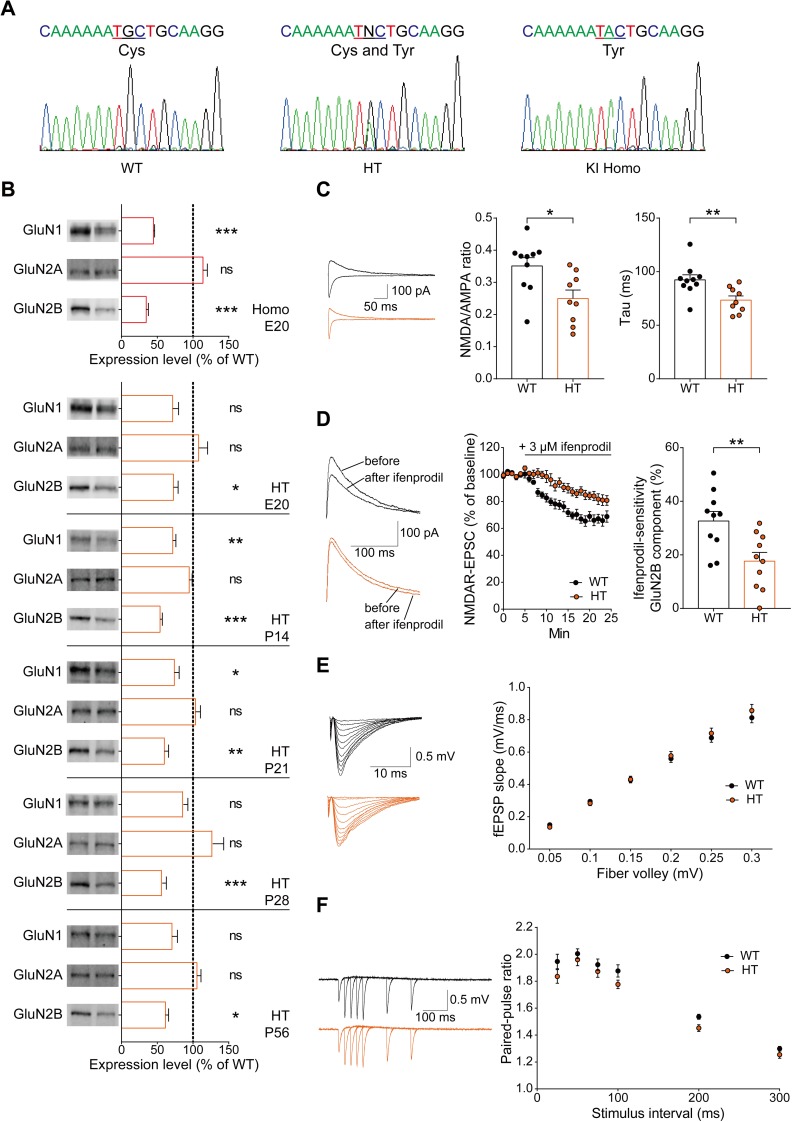
The GluN2B-C456Y mutation leads to decreases in GluN2B and GluN1 protein levels and GluN2B-containing NMDAR currents in mice.(A) Verification of the GluN2B-C456Y mutation in HT and homozygous (“Homo”) KI mice, and validation of its absence in WT mice, by DNA sequencing. (B) Decreased levels of GluN2B protein in the Grin2b+/C456Y brain. Whole-brain fractions from Grin2b+/C456Y mice at multiple developmental stages (E20, P14, P21, P28, and P56) were immunoblotted with anti-GluN1/2A/2B antibodies. Note that levels of GluN1 protein are also decreased, although to a lesser extent than those of GluN2B. For purposes of quantification, average levels of GluN1, Glu2A, and Glu2B proteins from Grin2b+/C456Y mice were normalized to those from WT mice. n = 4 mice for WT and HT, *P < 0.05, **P < 0.01, ***P < 0.001, Student t test. (C) Decreased ratio of evoked NMDAR- and AMPAR-mediated EPSCs (NMDA/AMPA ratio) at hippocampal SC-CA1 synapses of Grin2b+/C456Y mice (P19–23). Note the faster decay kinetics of the mutant NMDAR currents, indicative of a decrease in the GluN2B component. n = 10 neurons from 5 mice for WT, and 9 (5) for HT, *P < 0.05, **P < 0.01, Student t test. (D) Decreased proportion of ifenprodil-sensitive currents of GluN2B-containing NMDARs at SC-CA1 synapses of Grin2b+/C456Y mice (P21–23). n = 10 neurons (7 mice) for WT and HT, **P < 0.01, Student t test. (E) Normal levels of basal excitatory synaptic transmission at SC-CA1 synapses of Grin2b+/C456Y mice (P27–41), as shown by the input-output relationship of evoked EPSCs. n = 10 slices from 3 mice for WT and HT, one-way ANOVA. (F) Normal levels of paired-pulse facilitation at SC-CA1 synapses of Grin2b+/C456Y mice (P27–41). n = 10 slices (3 mice) for WT and HT, one-way ANOVA. The numerical data underlying this figure can be found in S3 Data. AMPA, alpha-Amino-3-hydroxy-5-methyl-4-isoxazolepropionic acid; AMPAR, AMPA receptor; E, embryonic day; EPSC, excitatory postsynaptic current; fEPSP, field excitatory postsynaptic potential; HT, heterozygous; KI, knock-in; NMDA, N-methyl-D-aspartate; NMDAR, NMDA receptor; ns, not significant; P, postnatal day; SC-CA1, Schaffer collateral-CA1 pyramidal; WT, wild type.